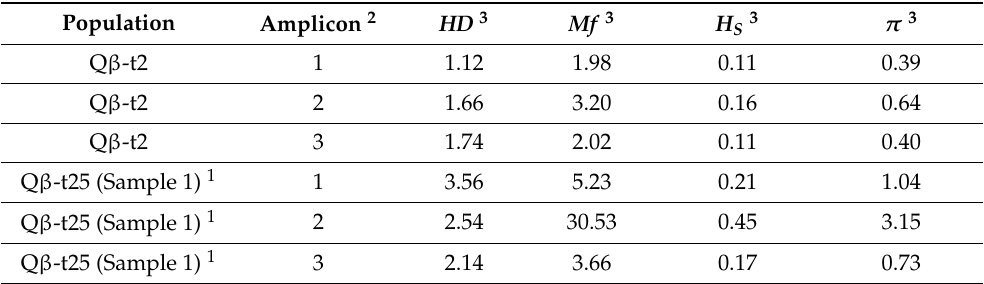
Table 1. Values of haplotypic density ( HD ), maximal mutation frequency ( Mf ), Shannon entropy nor- malised by the number of haplotypes ( H S ), and nucleotide diversity ( π ), obtained for the amplicons corresponding to Q β -t2 and Q β